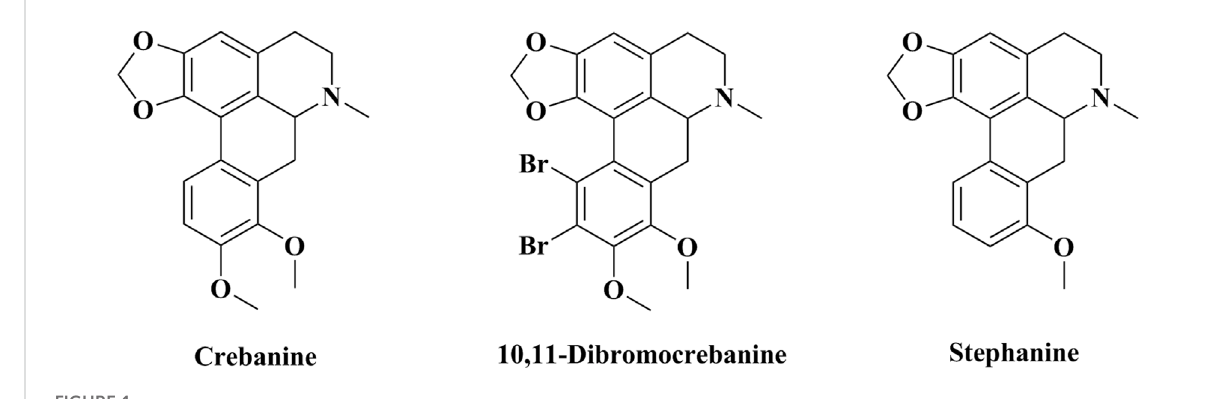
FIGURE 1 The chemical